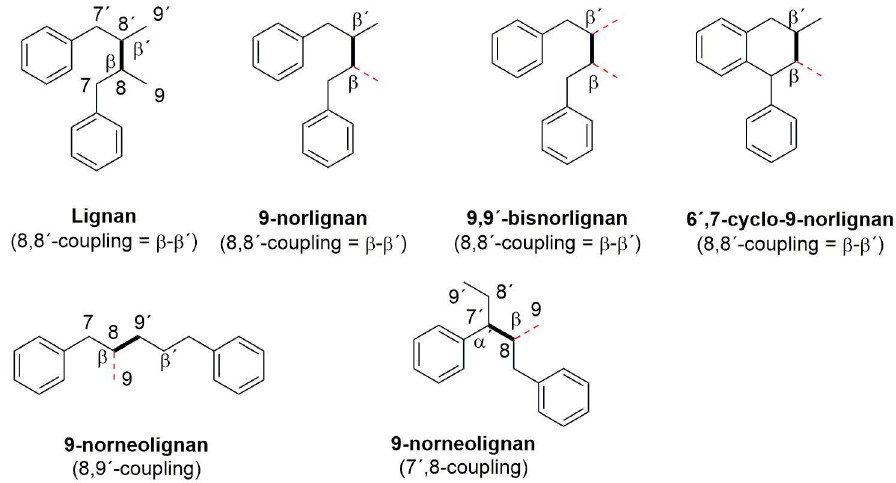
Figure 1. Fundamental structures for the lignan and different 9-norlignan and 9-norneolignan structures. Dotted (red lines) lines indicate the missing carbon-9